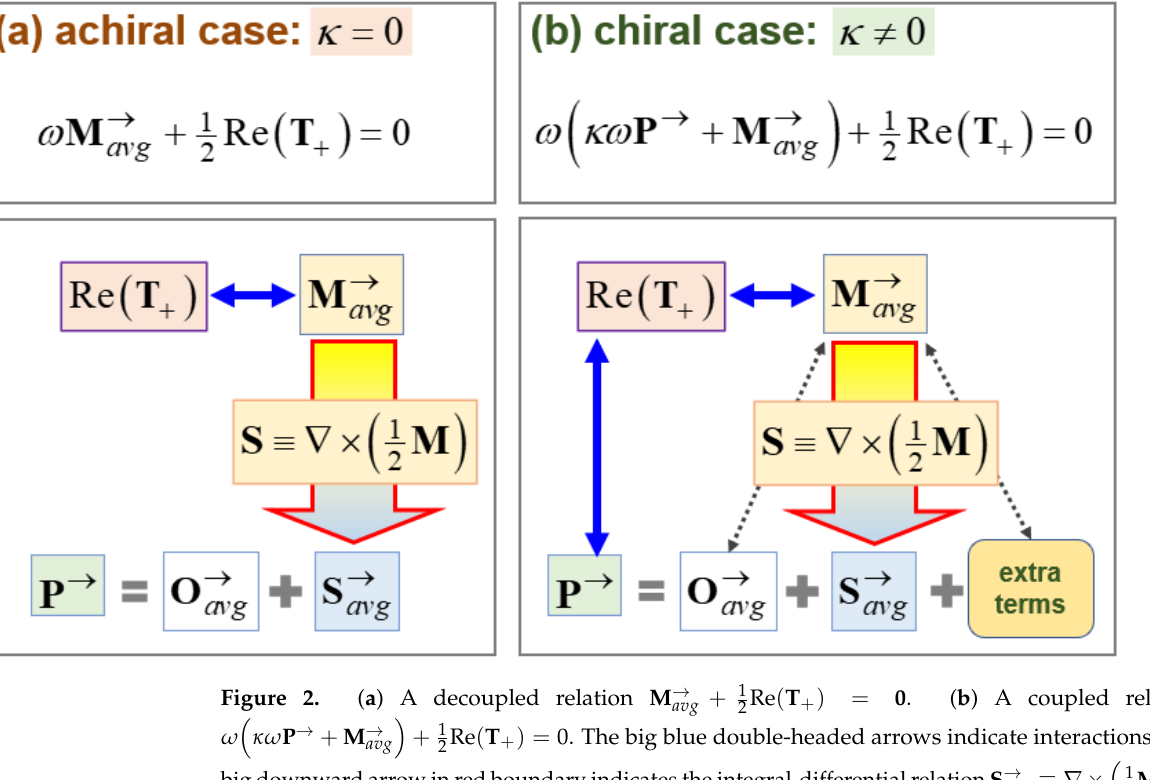
(cid:17) (cid:16) 1 M → avg . 2 → S by one avg